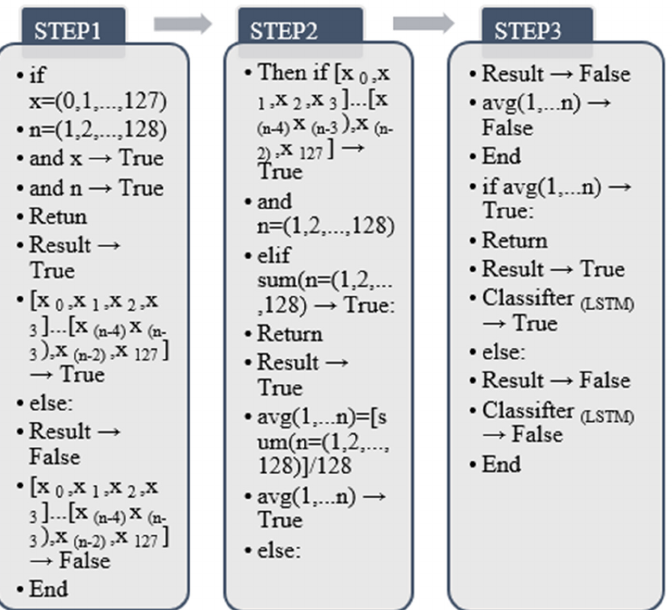
Figure 16. LSTM algorithm output diagram.